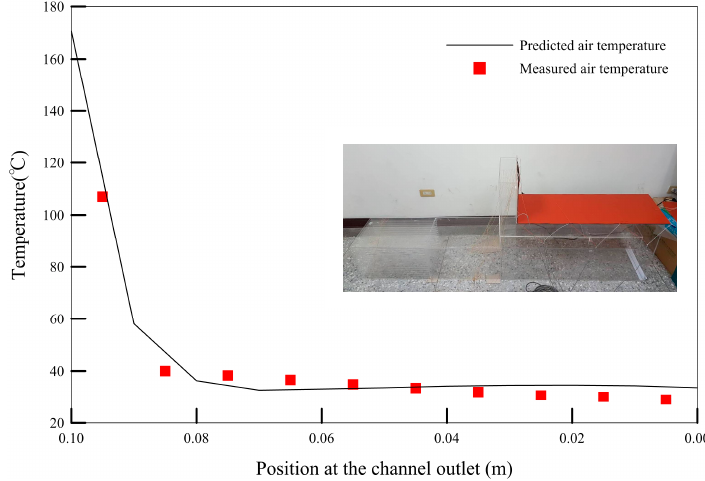
Figure 6. Comparison of simulation results and measurements (the outlet bottom is at X = 0).